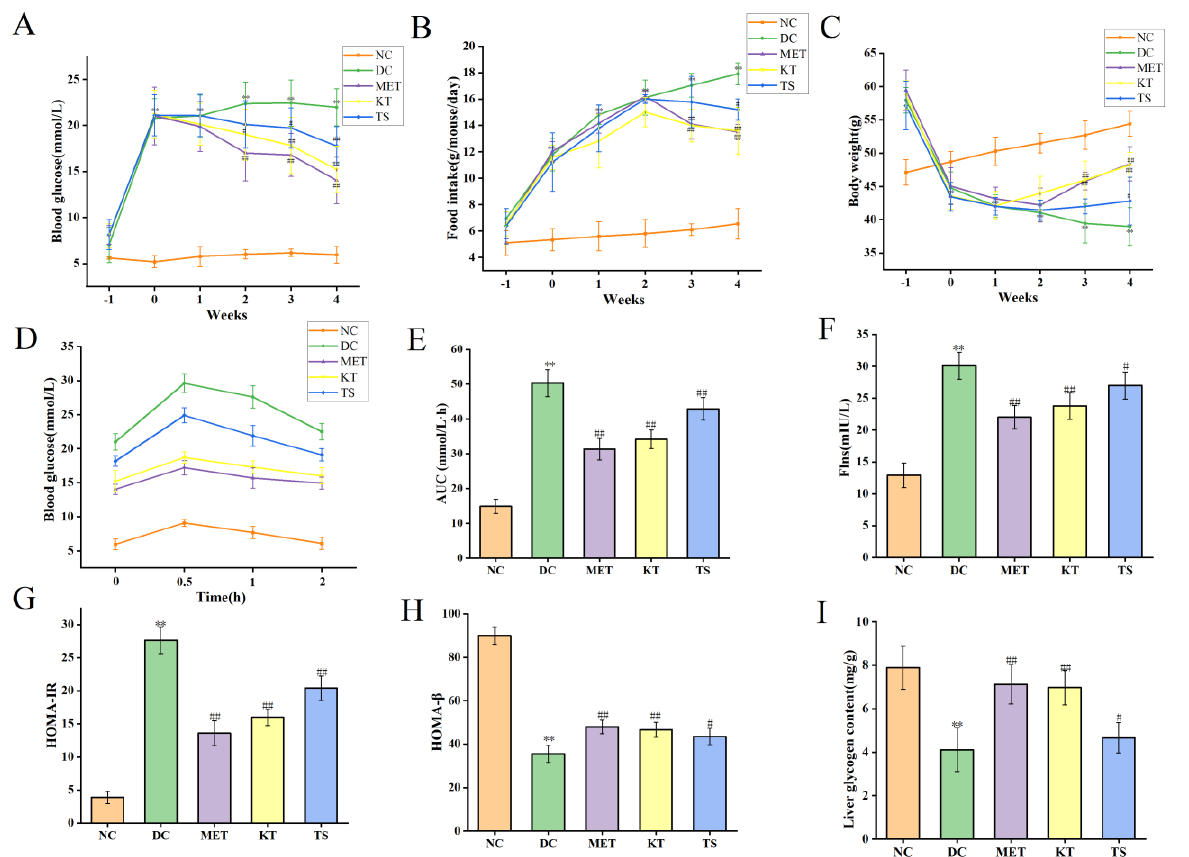
Figure 2. Effects of Kombucha on fasting blood glucose (FBG), food intake, body weight, glucose tolerance, insulin and glycogen contents in T2DM mice. ( A ) FBG; ( B ) Food intake; ( C ) Body weight; ( D ) Blood glucose levels of the oral glucose tolerance test (OGTT); ( E ) Area under the curve (AUC) of the OGTT; ( F ) Flns content in serum; ( G ) Homeostasis model assessment of insulin resistance index (HOMA-IR); ( H ) Homeostasis model insulin secretion index (HOMA- β ); ( I ) Liver glycogen level. ** p < 0.01 vs. normal; # p < 0.05, ## p < 0.01 vs. model.